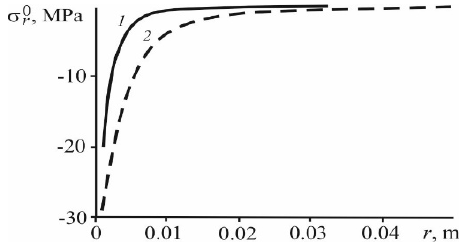
Figure 7. Change of residual stresses in experimental samples on depth (theoretical 1 and experimental 2 data) Because the degree of illumination of the film is proportional not only to the intensity of the FMF, but also to the exposure time (linear dependence), increasing the voltage limit can be obtained by reducing the exposure time (for example, reducing the exposure time to 10 mi– nutes). The graph of the obtained model is given in Fig.